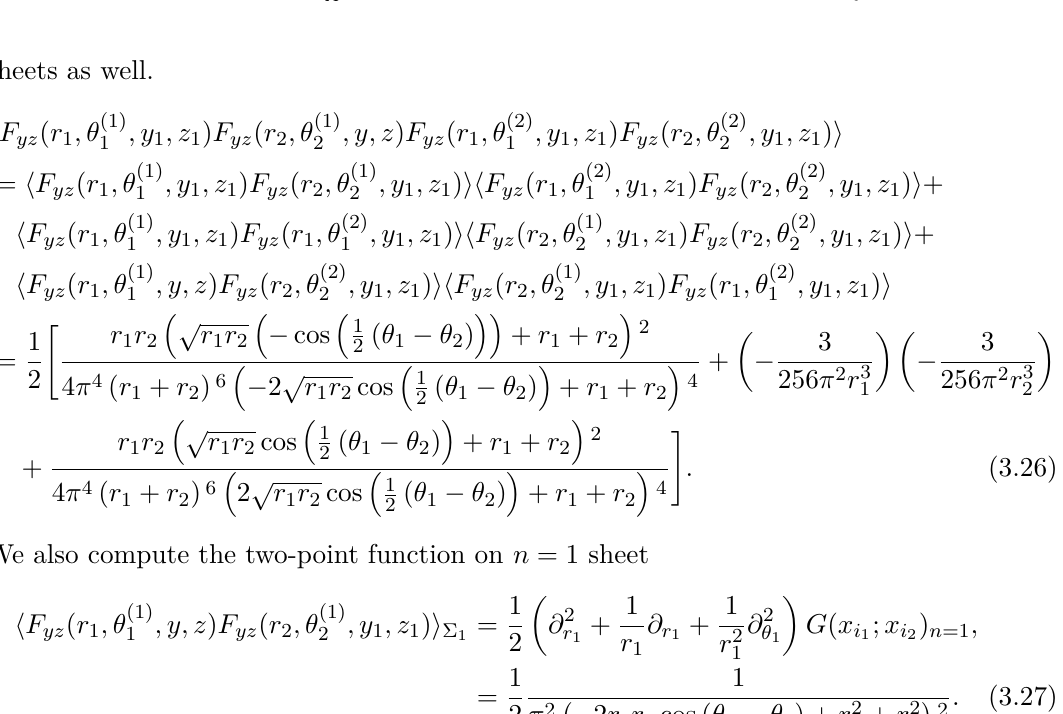
Figure 6. ∆ S (2) as a function of the center of the operators F yz A